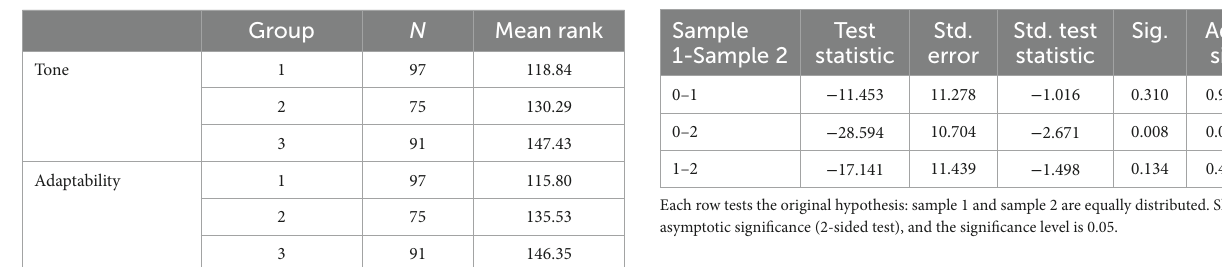
TABLE 11 The rank of Tone and Adaptability . TABLE 12 Paired comparison results ( Tone